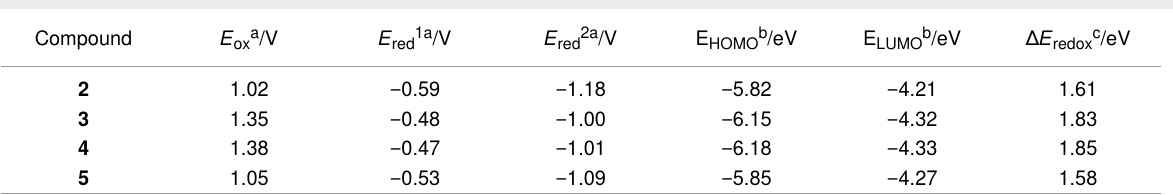
Table 1: Electrochemical properties of 2 – 5 .